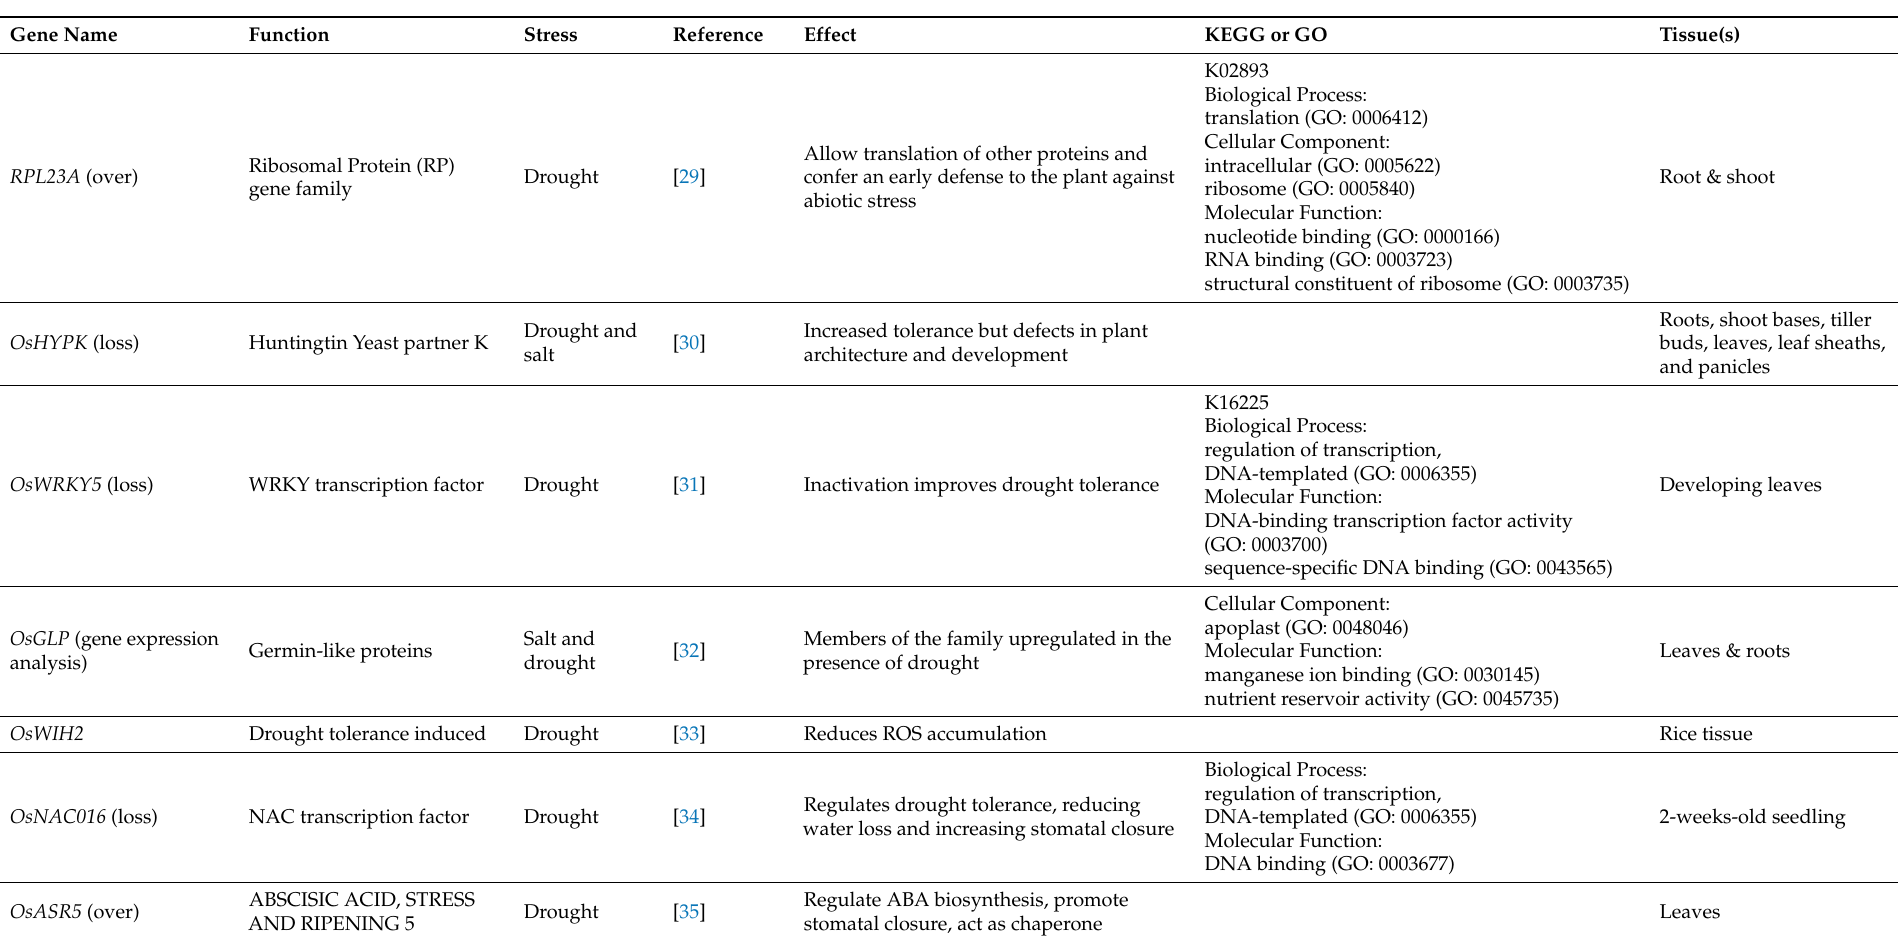
Table 1. Genes affecting traits associated with tolerance for water-limiting and drought stress conditions. The effects are related to the gene expression modifications indicated in the “Gene name” column. KEGG: Kyoto Encyclopedia of Genes and Genomes. GO: Gene